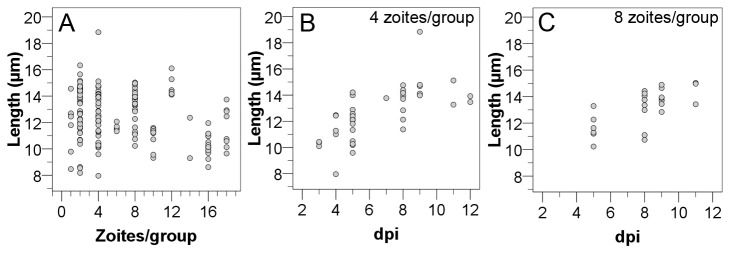
Size of intracellular

I

. suis
 zoites in intestinal porcine epithelial cells (IPEC-J2).The correlation between length and group size (A) and the correlation between length and dpi for groups of 4 zoites (B) and 8 zoites (C) are shown. Groups of 4 zoites were first detected at 3 dpi, groups of 8 at 5 dpi. A group was defined as the totality of merozoites derived from one dividing mother zoite based on the arrangement of zoites in pairs or rosettes; dpi, days post infection.